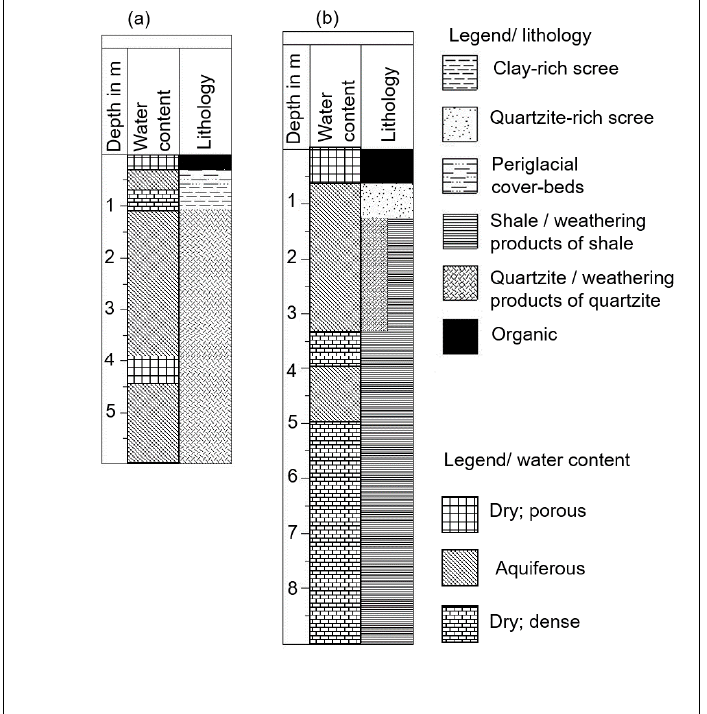
Figure 8. Boreholes: drained part of "Thranenbruch": ( a ) B3, ( b ) B4.